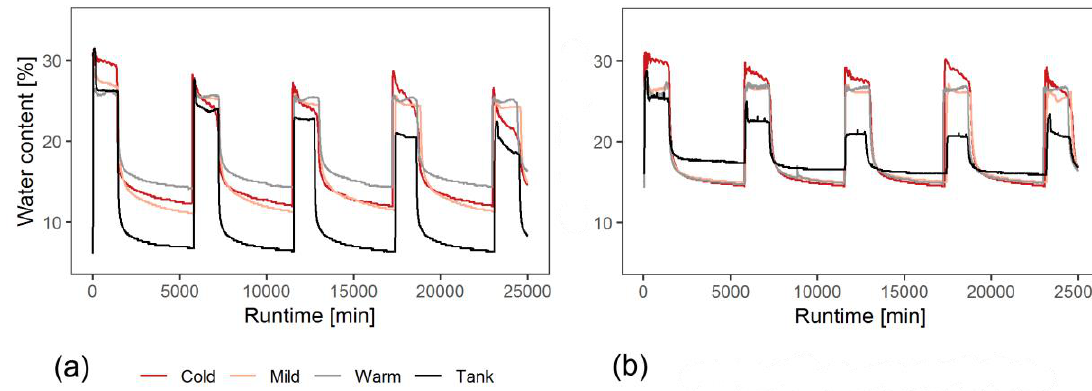
Figure 5. Comparison of water content measurements for three different climate types in the field (cold, mild, warm) and laboratory data (tank) for scenario 3 in ( a ) 0.3 m depth and ( b ) 0.7 m depth.